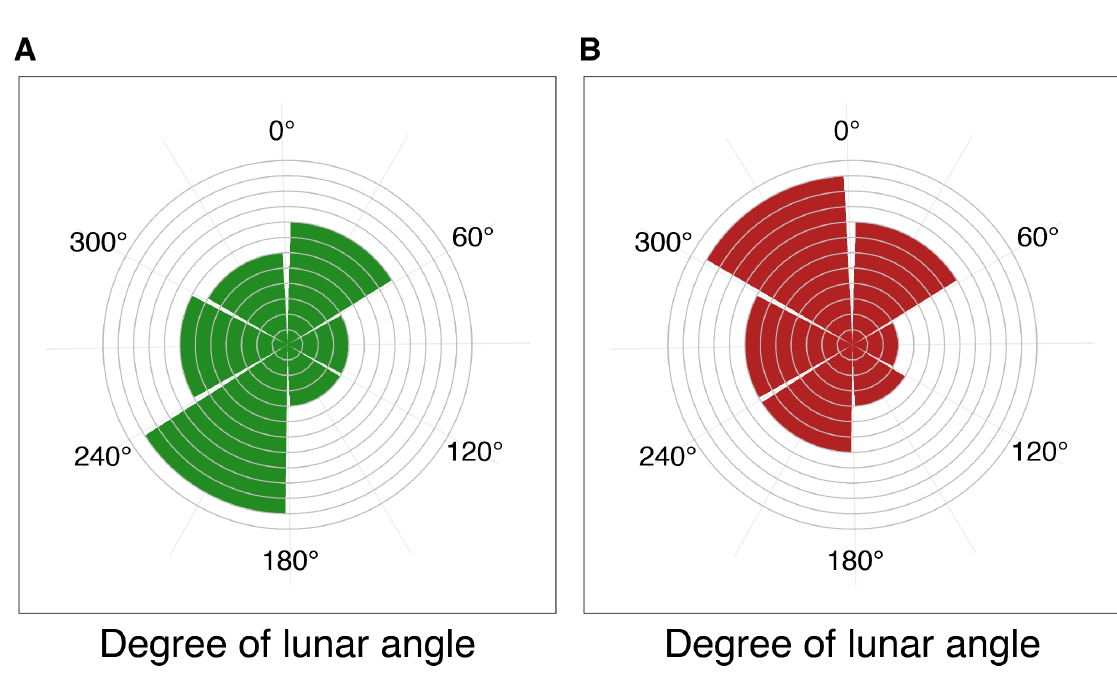
Figure 3. Circular histogram showing counts of (A) the originally assigned breeding start dates and (B) the originally assigned peak breeding dates under different lunar phases for the period 1982–2021 (e.g., the breeding season started eight times under a moon phase with a lunar angle between 0° and 60°). Lunar angles, initially in radians, were back- transformed to degrees, so that the new moon is at 0° and full moon is at